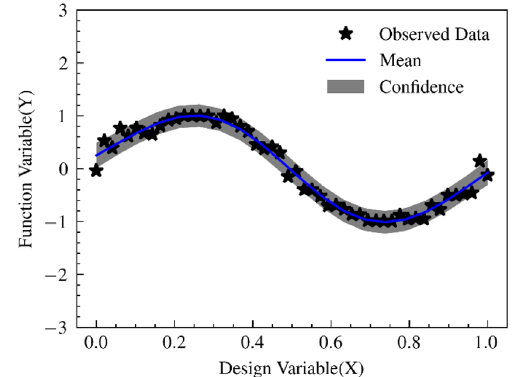
Fig. 6 GP model on a simple